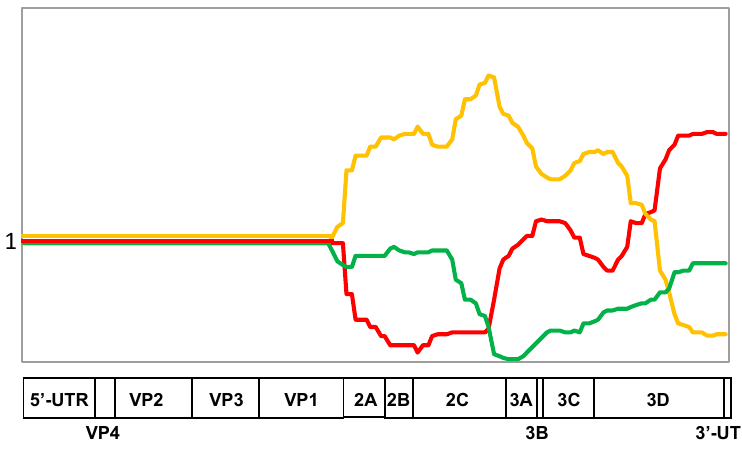
Figure 2. The occurrence of type-specific genomic segments in the normalized common set of recombinants of all three serotypes. The set of recombinants of each serotype is normalized to 1. Sequences derived from these serotypes are depicted in red, orange, and green respectively.